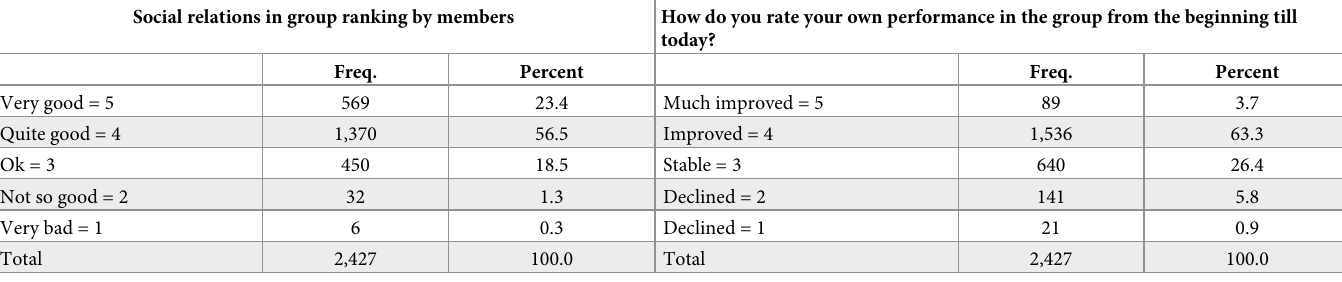
where TWO represents individual outgroup trustworthiness which we hypothesize is Table 5. Social relations in groups and assessment of own performance. Social relations in group ranking by